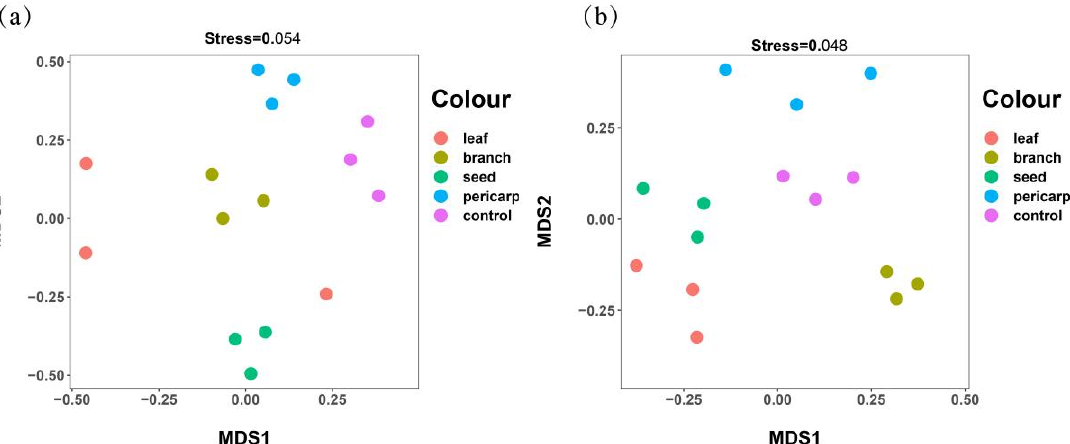
Figure 7. The non-metric multidimensional scaling (NMDS) analysis was based on the operational taxonomic unit (OTU) (97% similarity clusters) abundance for soil fungi ( a ) and soil bacteria ( b ). The abscissa (NMDS 1) and ordinate (NMDS 2) are two sorting axes. Each point in the figure represents a sample, the same color indicates the same group, and similar samples gather together. Large differences between samples are indicated by longer distance between points in the figure. Stress < 0.1 indicates a good ranking. Stress < 0.05 is very representative.